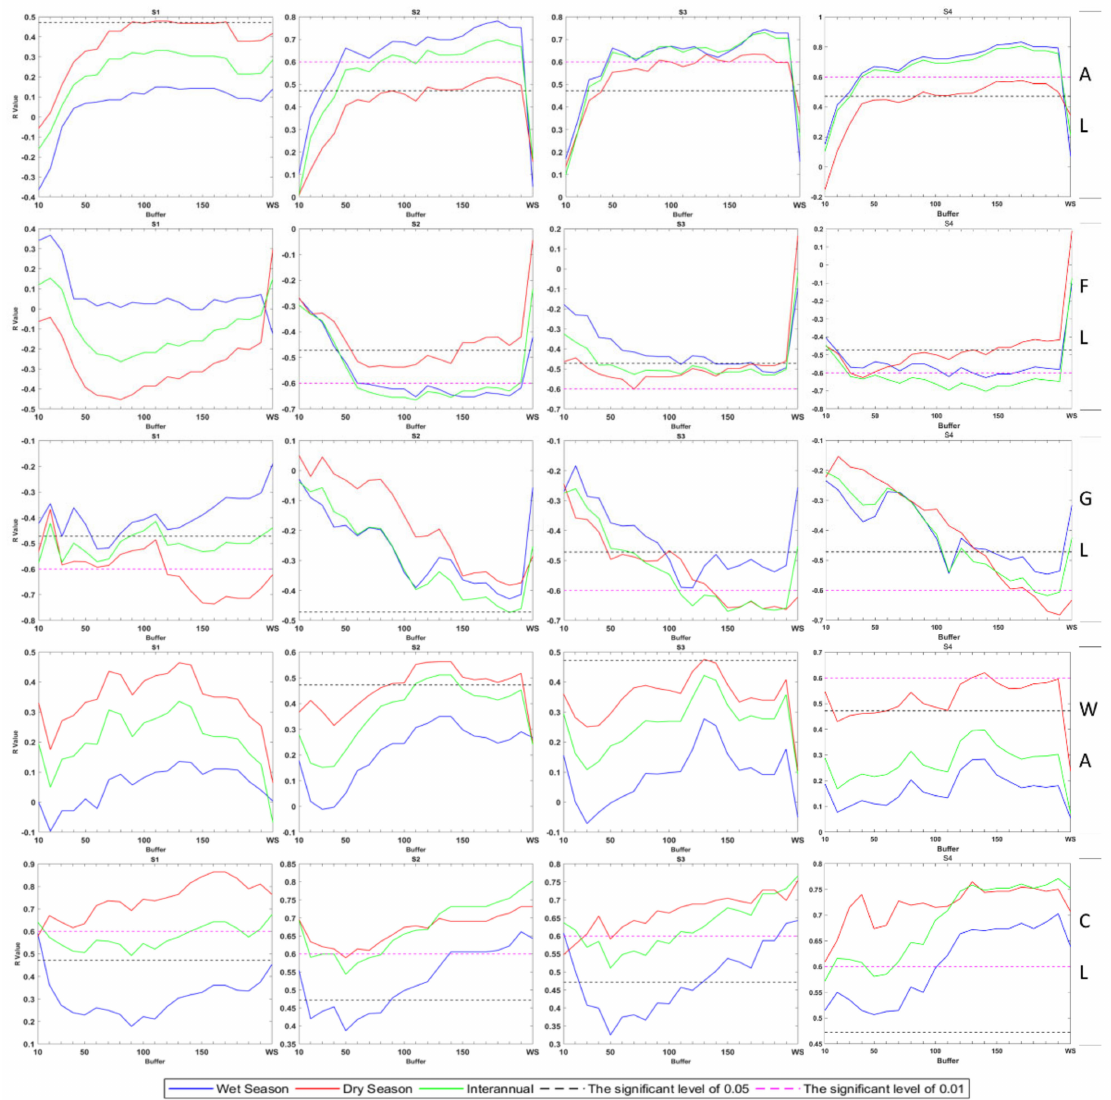
Figure 12. Correlation index of COD MN and different land use types in different seasons in S1, S2, and S3. Each row from the top to the bottom represents a type of land